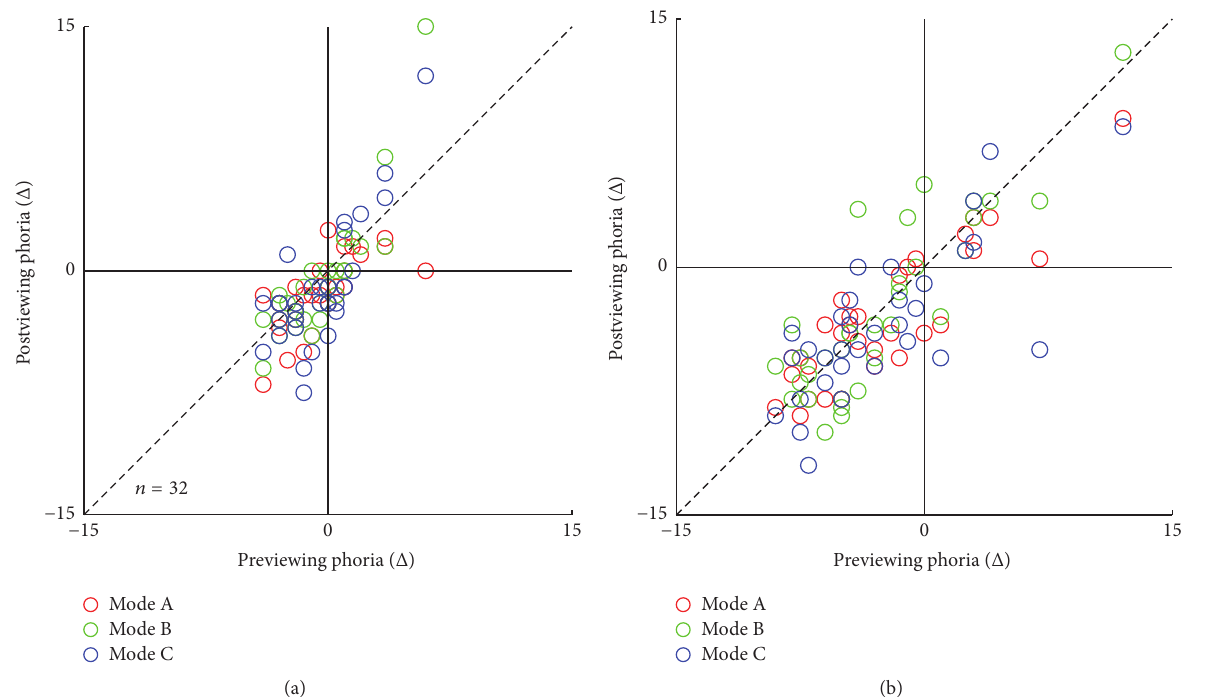
Figure 6: The effect of a 90-minute 3D viewing session on phoria. The effects of a 90-minute 3D viewing session on distance phoria (a) and near phoria (b). An identity line is plotted in each panel (𝑋 = 𝑌)